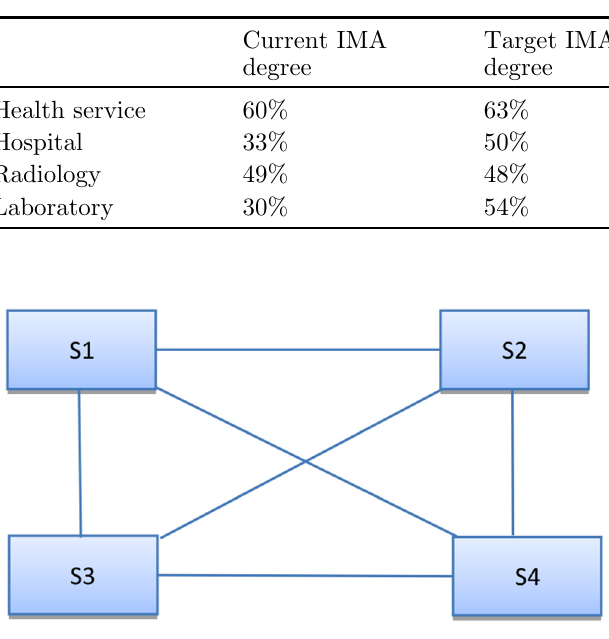
Table 4. Planni fi ed improvement of e-health process.